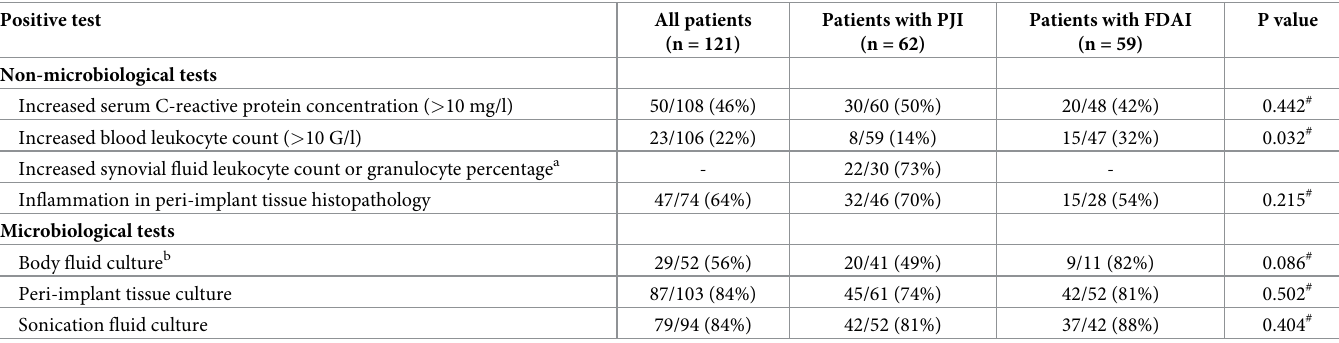
Table 3. Diagnostic tests for orthopedic implant-associated infections. Positive